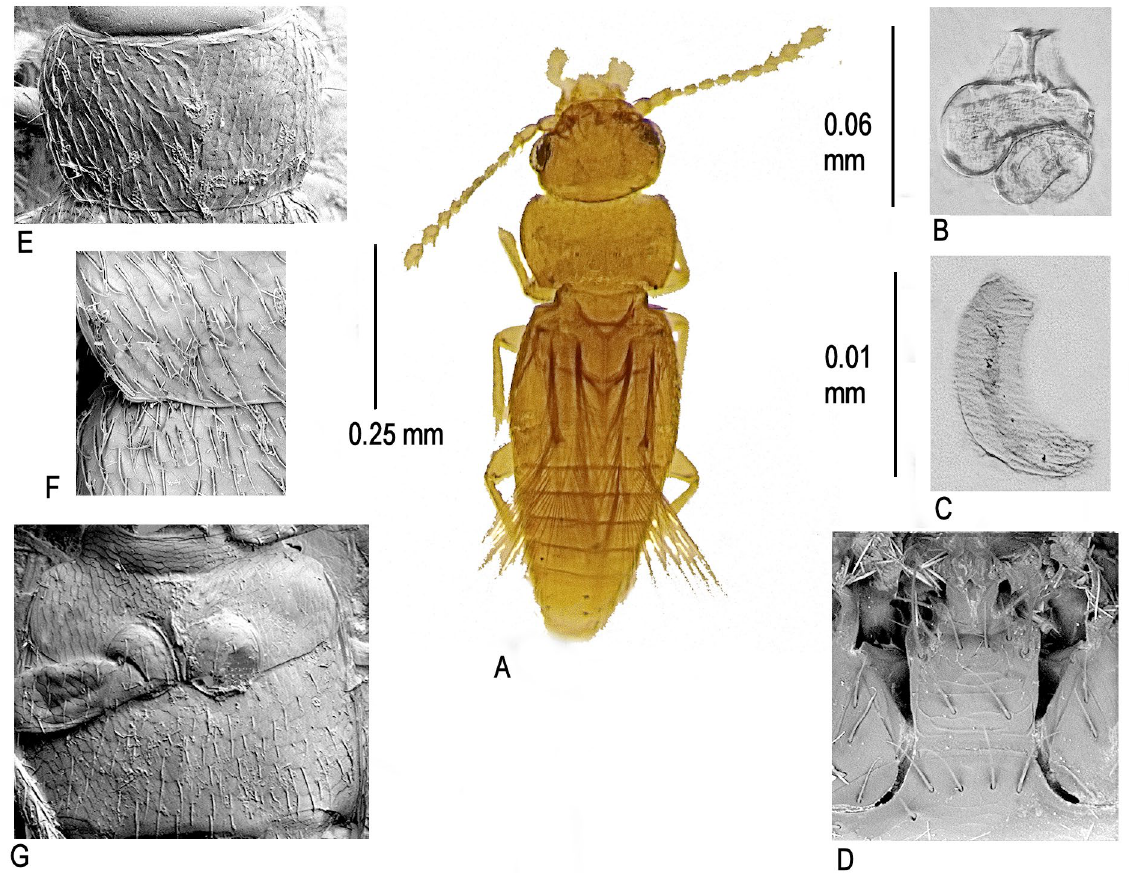
Fig. 13. Ptinella alisonae sp. nov. A . Habitus. B . Spermatheca. C . Aedeagus. D . Mentum and submentum ×1340. E . Pronotum ×620. F . Pronotal hind angle ×1380. G . Meso- and metaventra